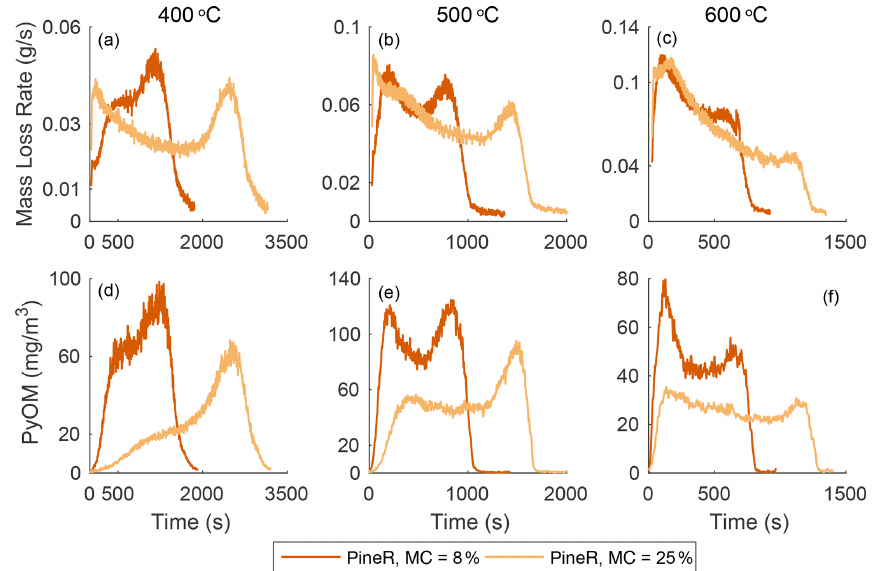
Figure 3. (a–c) Comparison between real-time mass loss rates and (d–f) mass concentration of PyOM at low and high MCs for PineR wood samples.